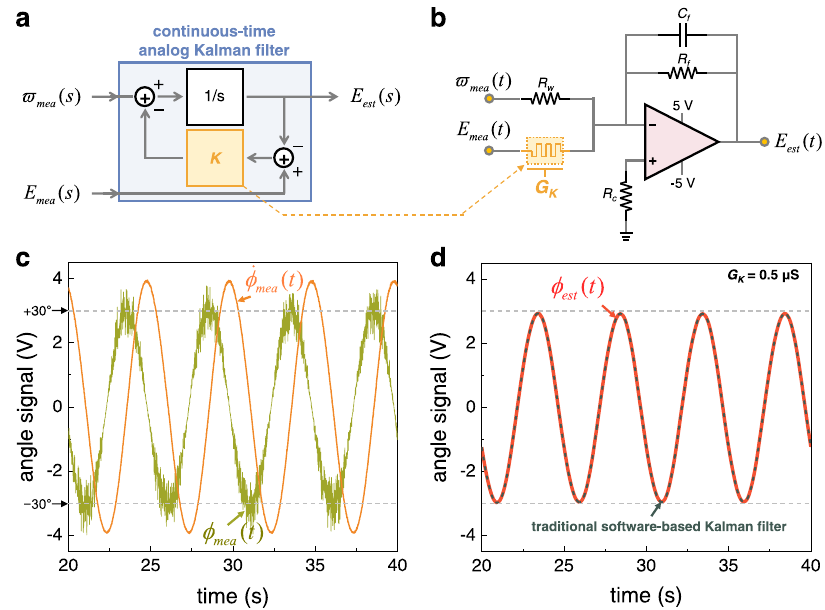
Fig. 4 Continuous-time analog Kalman fi lter circuit. a Block diagram of the signal fi ltering (Euler angle estimation) with continuous-time analog Kalman fi lter. The Laplace transform of the complex frequency is denoted by S . The Euler angle ( E ð s Þ ) can be estimated through the continuous-time analog est Kalman fi lter algorithm, where ϖ mea ð s Þ signal obtained by the gyroscope and E mea ð s Þ signal obtained by the accelerometer are generated from the microcontroller. b Circuit schematic diagram of the memtransistor-based analog Kalman fi lter, where the Kalman gain is recon fi gurable by adjusting the conductance of the memtransistor (i.e., K ¼ G K = C f ). In our experiment, G K = 0.5 μ S, R w = 100 k Ω , R f = 700 k Ω , R c = 100 k Ω , and C f = 10 μ F were used. c Two input signals ( ϕ mea ð t Þ and _ ϕ mea ð t Þ ) for the roll angle. d Filtered output (estimated roll angle, ϕ est ð t Þ ) by the continuous-time analog Kalman fi lter circuit. The output accurately estimated the roll angle oscillation (i.e., ±30°), and it shows a good agreement with the result obtained by the traditional software-based Kalman fi